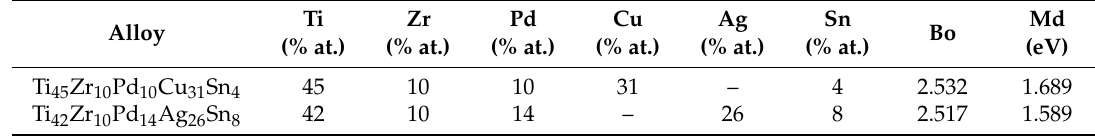
Table A2. Compositions and orbital method parameters of considered alloys.